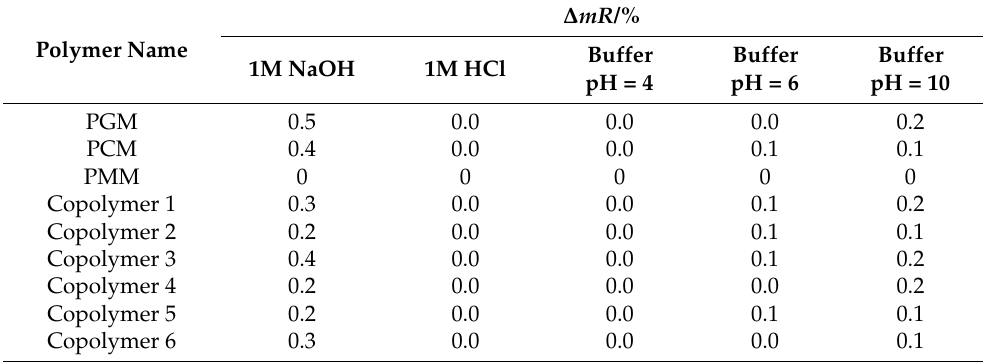
Table 7. Percentage change in mass loss ( ∆ mR ) for samples conditioned at 120 ◦ C (series